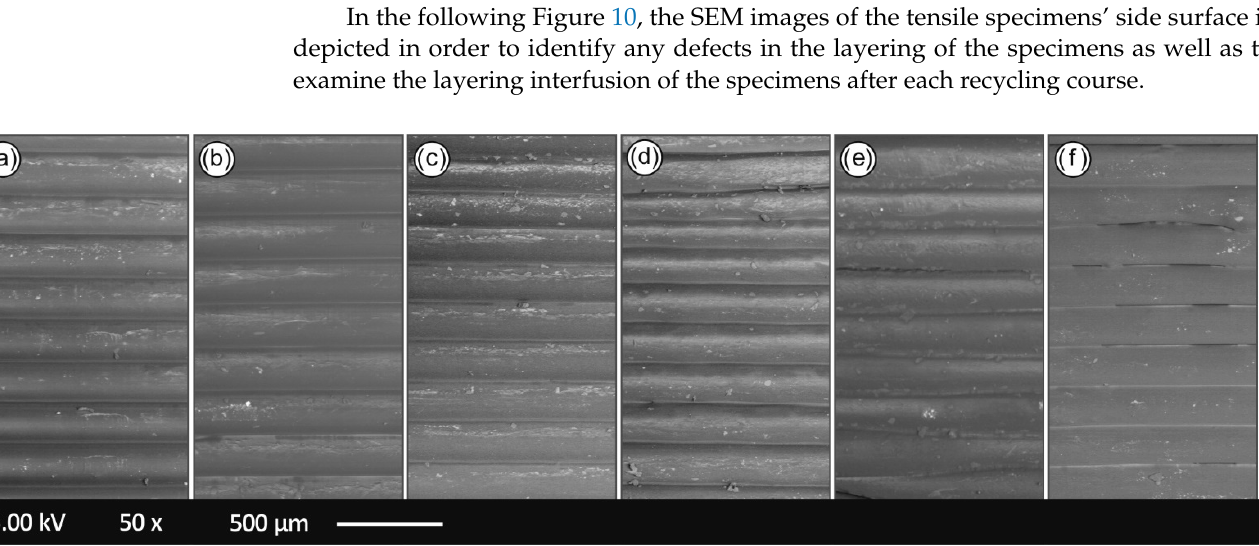
Figure 10. Specimens’ side surface SEM images: ( a ) 1st recycling course, ( b ) 2nd recycling course, ( c ) 3rd recycling course, ( d ) 4th recycling course, ( e ) 5th recycling course and ( f ) 6th recycling course.